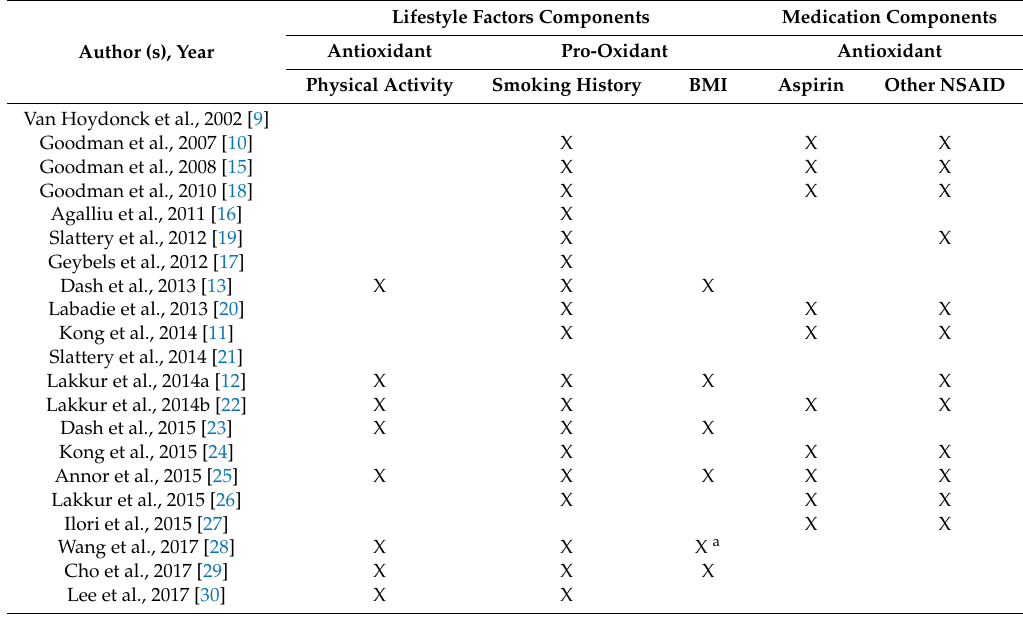
Table 2. Lifestyle factors and medication components included in each a priori Oxidative Balance